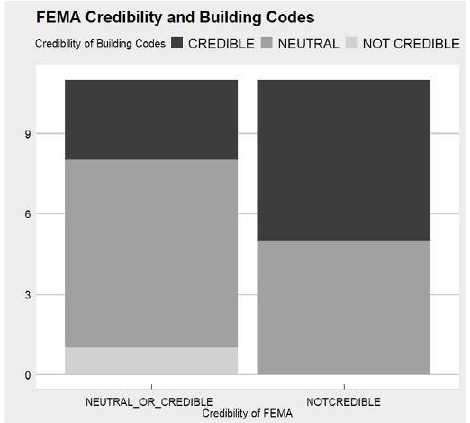
Figure 2: Perceived credibility of FEMA and building codes/enforcement of base flood eleva- tion/freeboard